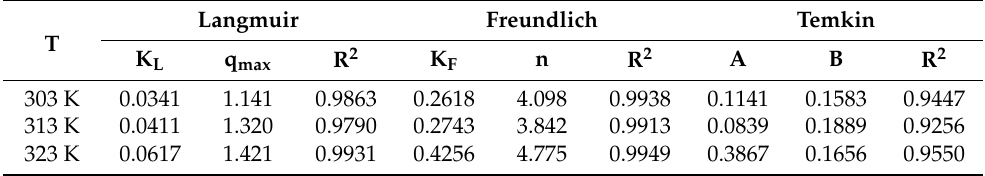
Table 2. Isotherm parameters for copper ion adsorption on the prepared